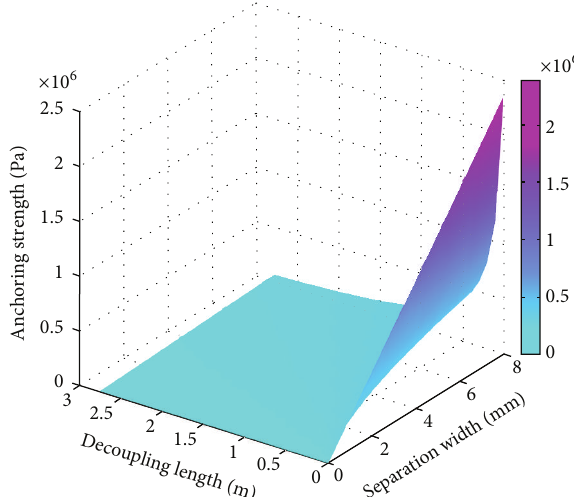
Figure 9: Shear stress distribution of the damaged interface when separation occurs near the loading end.